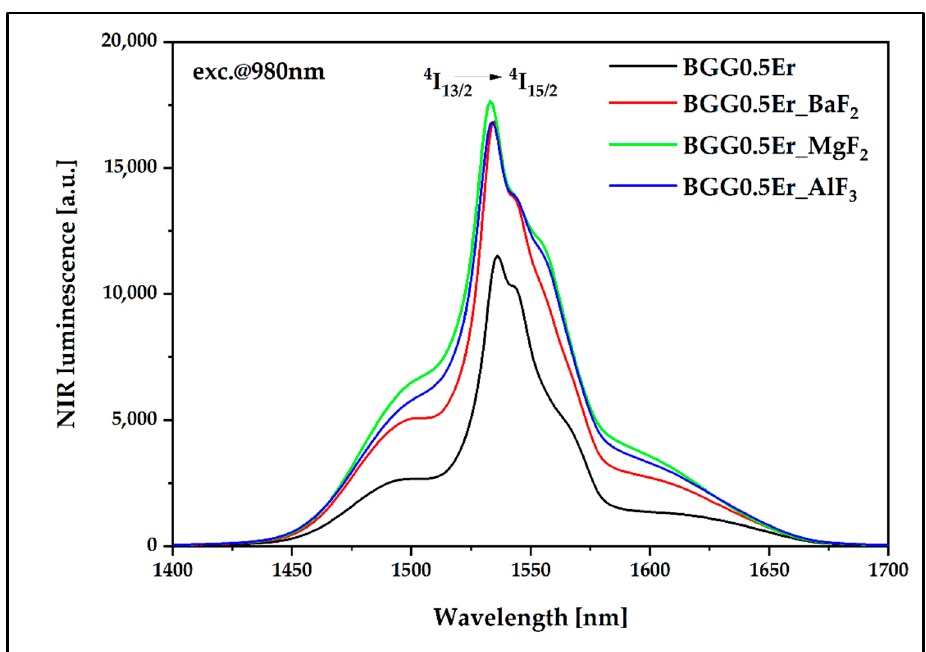
Figure 16. Luminescence spectra of Er 3+ -doped BGG glass modified by different fluoride compounds under 980 nm laser excitation.